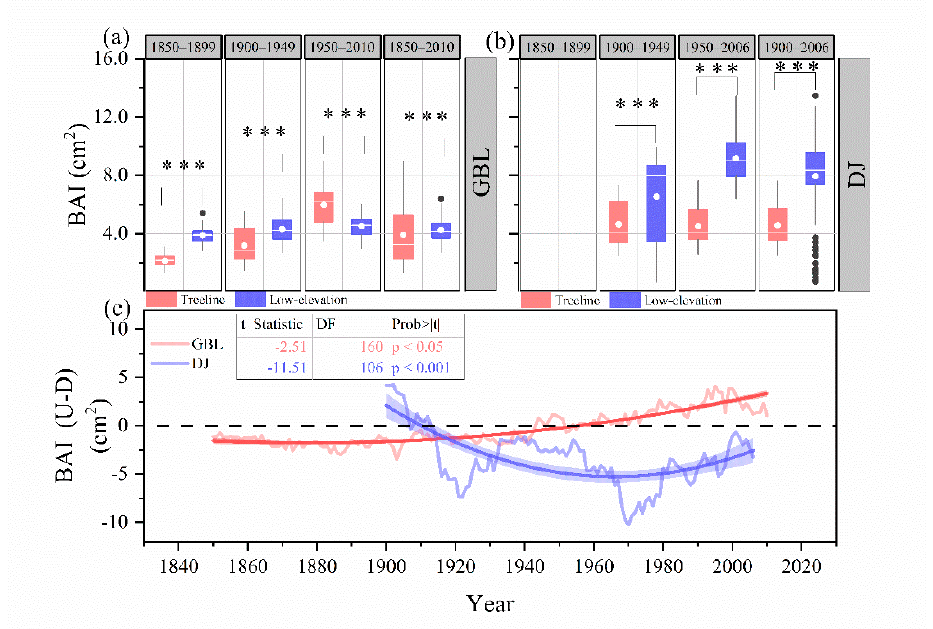
Figure 2. Comparisons of the mean values of tree-ring BAI between the treeline (U) and low-elevation (D) plots for the two elevational transects GBL and DJ over different time periods ( a , b ), and ( c ) the difference (U-D) in BAI between treeline and low elevation. The black dots represent outliers as judged by more than 3 standard deviations departed from the mean values. *** denotes significant difference of means between the compared groups at p < 0.001 level. The bold lines in ( c ) are regression lines and the shaded area denotes the 95% confidence intervals of the regressions.